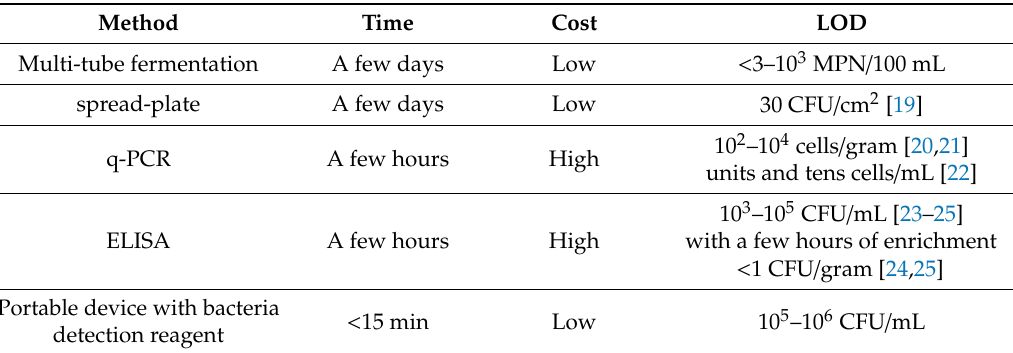
Table 1. Comparison of current detection